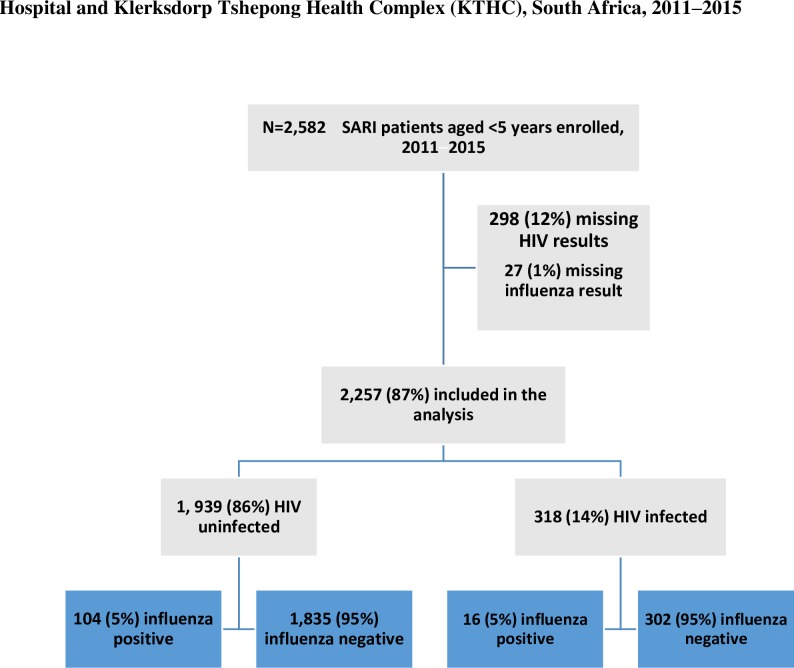
Flow diagram showing cohort of children aged < 5years, South Africa, January 2011 to December 2015.